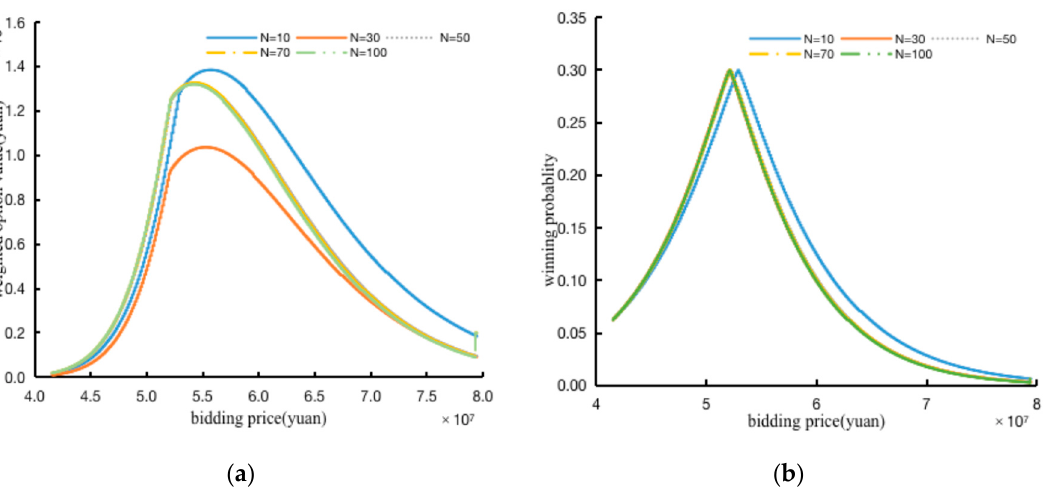
Figure 7. Sensitivity analysis of the number of competitors. ( a ) Numbers sensitivity; ( b ) Numbers sensitivity. (C t = 50,000,000; b =10; n = 1.1; u = 0.3; r = 0.01; σ = 0.2 ; T-t = 0.5 ; AP comps = 52.79 million).